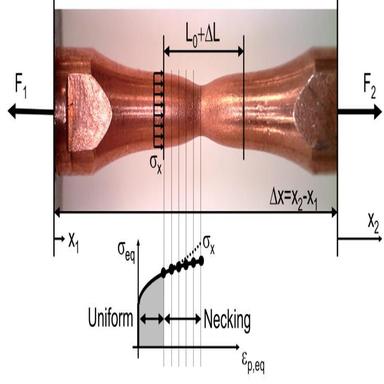
Scheme of force and displacement applied to a specimen during a tensile test. Comparison between axial and equivalent stress in uniform and necking phases as a function of the equivalent plastic strain.